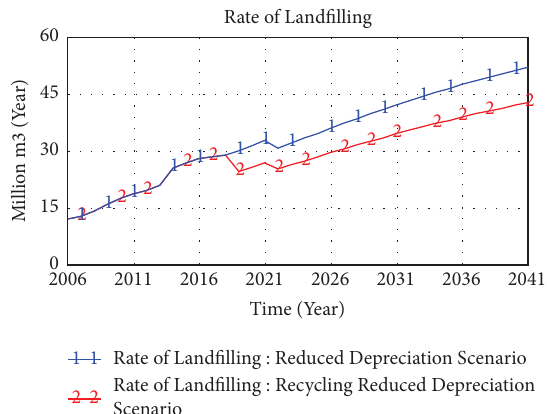
Figure 13: Te trend of landflling rate in the depreciation reduction scenario for both